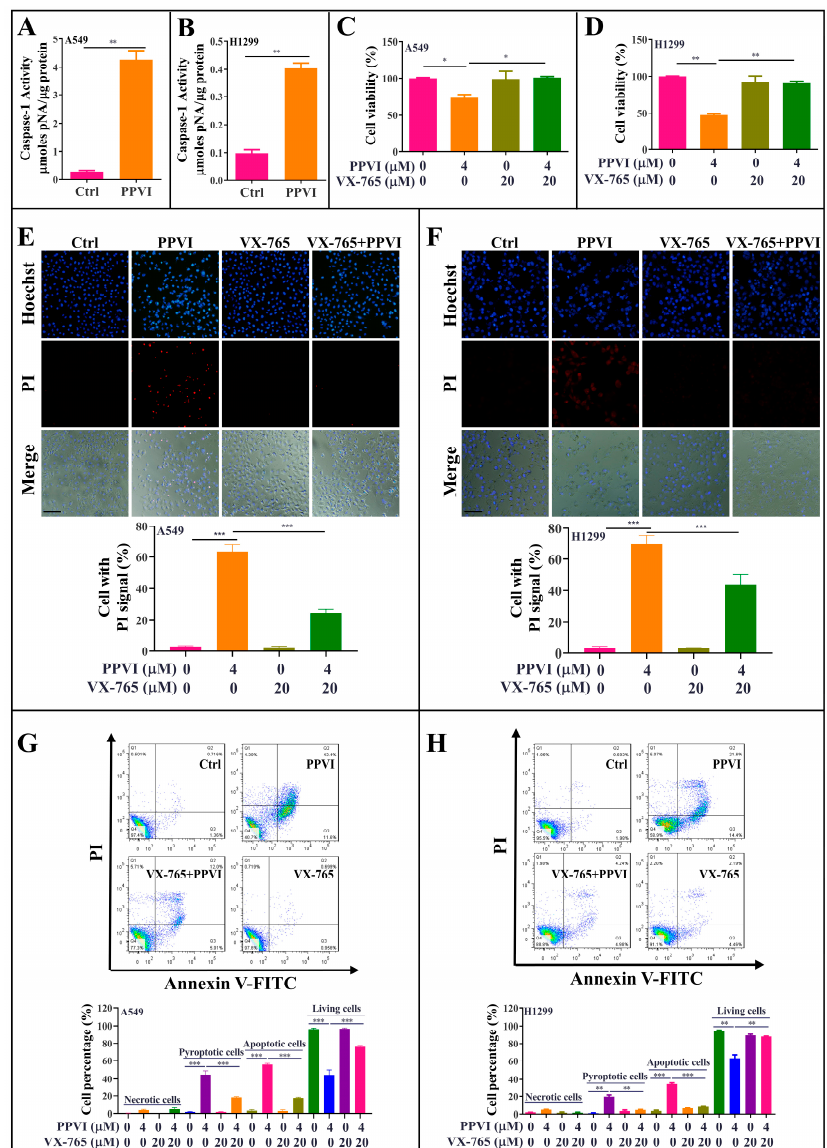
Figure 3. PPVI induces cell death via the activation of caspase-1 in A549 and H1299 cells. A549 cells ( A ) and H1299 cells ( B ) were treated with 4 µM PPVI for 24 h; the activated caspase-1 were then measured by using a Caspase-1 Activity Assay Kit (Colorimetric) according to the manufacturer’s instructions. Bar chart indicated the amount of pNA in A549 and H1299 cells. A549 cells ( C ) and H1299 cells ( D ) were treated with PPVI or co-treated with PPVI and VX-765 at the indicated concentration for 24 h. After treatment, the cytotoxicity was measured by using MTT assay. Bar chart indicates the cell viability of A549 and H1299 cells; bars, S.D. * p ≤ 0.05; ** p ≤ 0.01. A549 cells ( E ) and H1299 cells ( F ) were treated with PPVI or co-treated with PPVI and VX-765 at the indicated concentration for 24 h. The cells were then stained with 2 µ g / mL PI (red, staining dying cells) plus 2 µ g / mL Hoechst 33342 (blue, staining all cells) for 10 min, and observed by fluorescent microscopy. Bar chart indicates the percentage of cells with PI signal compared to blue signal. Magnification: 10 × , Scale bar: 100 µ m. Necrotic cells, pyroptotic cells, apoptotic cells or living cells of A549 cells ( G ) and H1299 cells ( H ), treated as indicated graded concentrations, were measured by flow cytometry using an annexin V-FITC / PI apoptotic detecting kit. Annexin V - / PI + indicated the necrotic cells, annexin V + / PI + indicated the pyroptotic cells, annexin V + / PI − represented apoptotic cells and annexin-V − / PI − represented living cells. Bar chart indicates the percentage of necrotic cells, pyroptotic cells, apoptotic cells and living cells; bars, S.D. ** p ≤ 0.01, *** p ≤